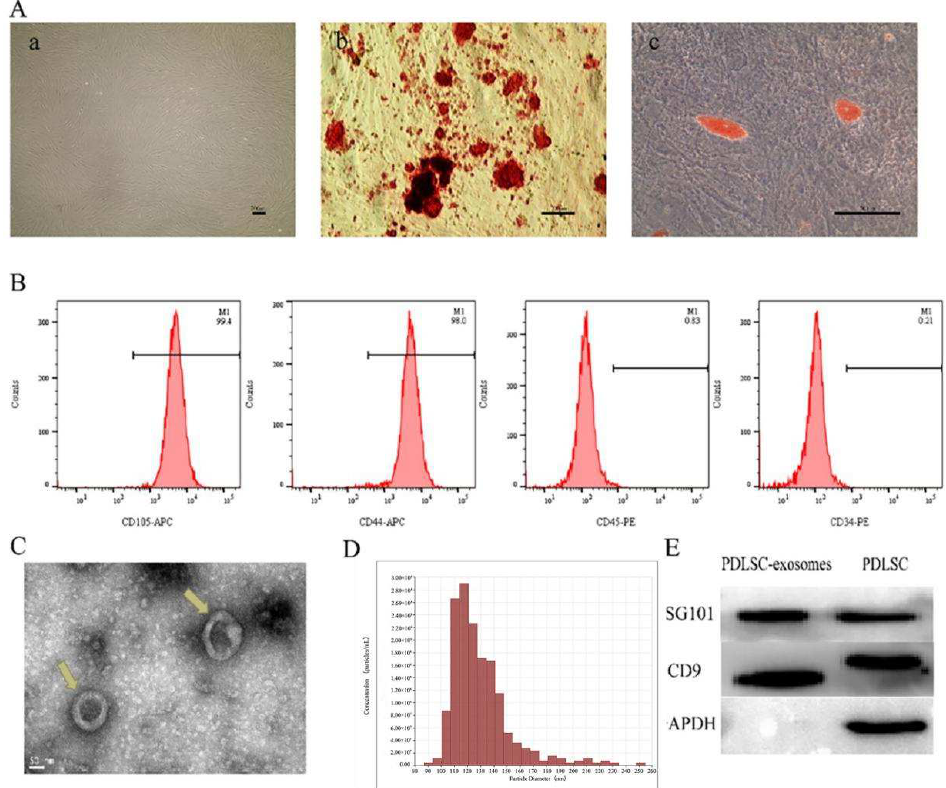
Figure 1. Characterization of PDLSCs and PDLSCs-derived exosomes. ( A ) Characterization of PDLSCs ( a ) Representative images of PDLSCs. Spindle shape with vortex distribution ( b ) Representative images of osteogenesis of PDLSCs stained with Alizarin red staining. A large number of red mineralized nodules were observed. ( c ) Representative images of adipogenesis of PDLSCs stained with Oil Red O. Red lipid droplets were formed. ( B ) Flow cytometric analysis of surface markers CD105, CD44, CD45, CD34 in PDLSCs. CD105 and CD44 are highly expressed, while CD45 and CD34 are low expressed. ( C ) Exosomes morphology of a cup-shape or circle observed by TEM (indicated by the yellow arrowheads) . ( D ) Particle size distribution of exosomes concentrated between 90 and 150 nm detected by TRPS. ( E ) Western blot analysis of the exosomal markers TSG101 and CD9.